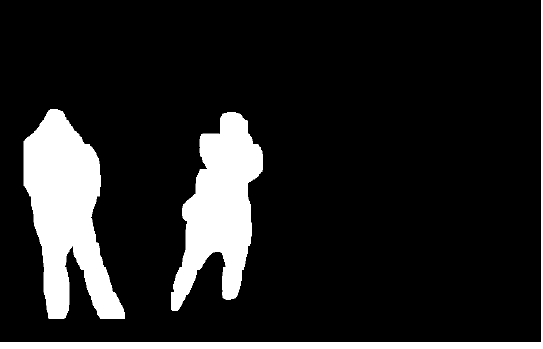
Figure 7. Final output of our system after the filtering part of our post-processing module is applied to Figure